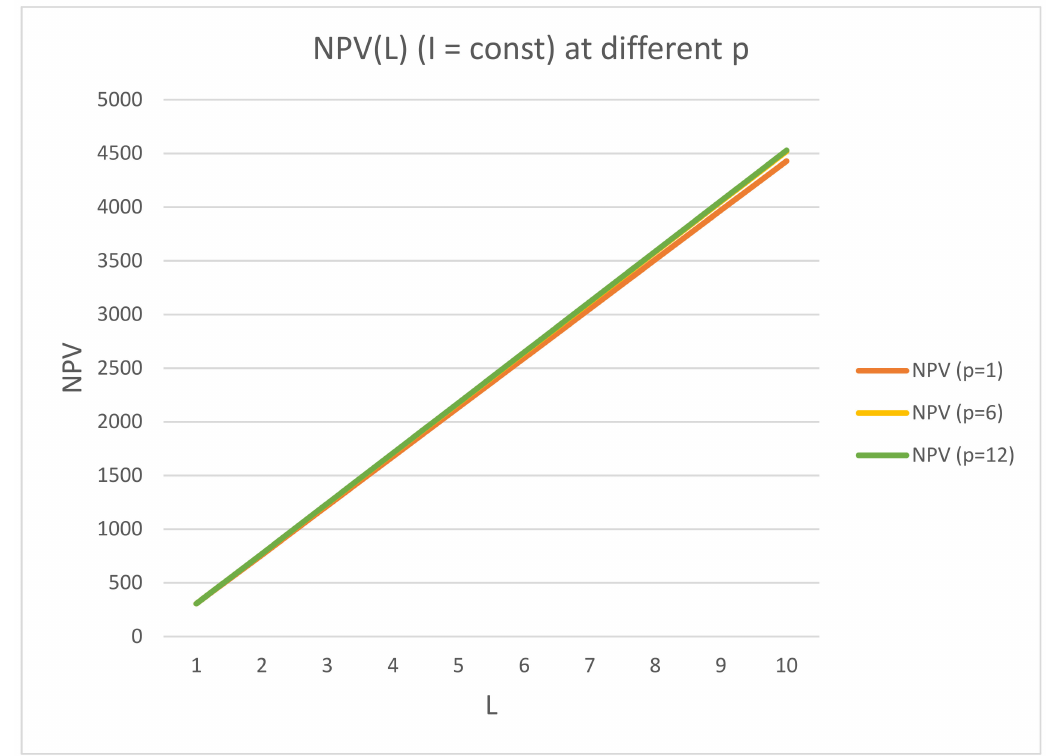
Figure 10. Dependence of NPV on leverage level L at k 0 = 0.22, k d = 0.14 and different p = 1, 6, 12 for a three-year project.